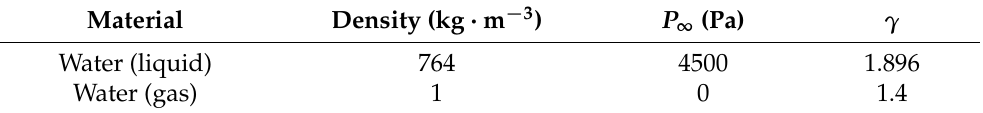
Table 2. Fluid materials